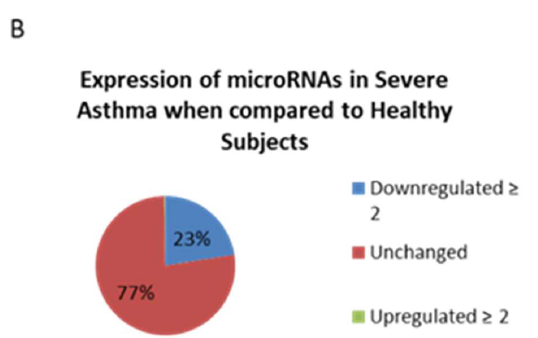
Figure 2. MicroRNA cargo reduced in nanovesicles from severe asthma BALF. ( A ). Heatmap showing unsupervised clustering of SA ( n = 12) and HC ( n = 8) ( B ). Comparative levels of microRNAs in nanovesicles according to fold expression (SA / HC). Statistics ( p value and FDR) according to NIA Array analysis software ( p ≤ 0.05). SA: Severe asthma. HC: Healthy control. BALF: Bronchoalveolar lavage fluid. FDR: False discovery rate.